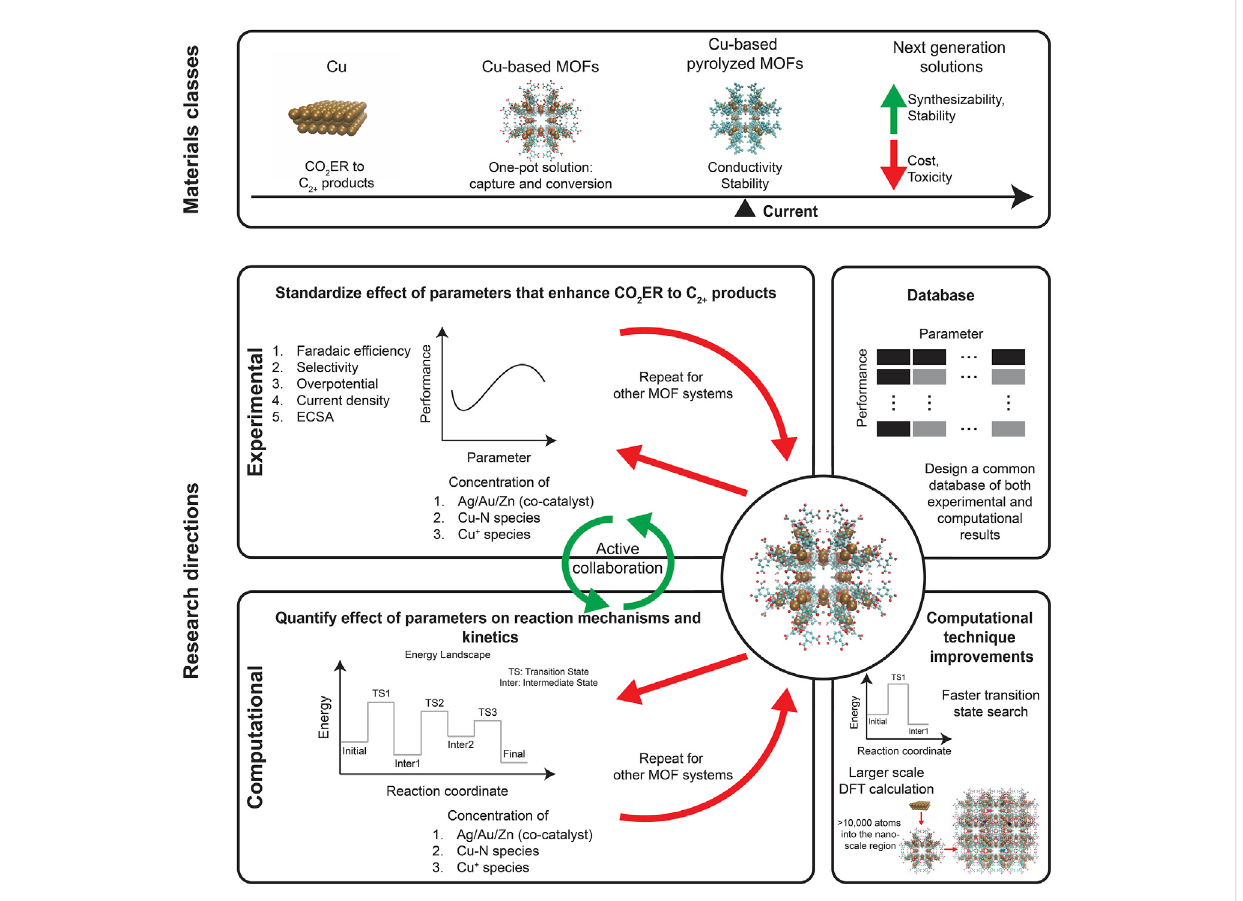
FIGURE 2 The materials classes involved in the CO 2 ER to C 2+ products: each successive progression highlights an improvement over the prior group. Future research directions are depicted.